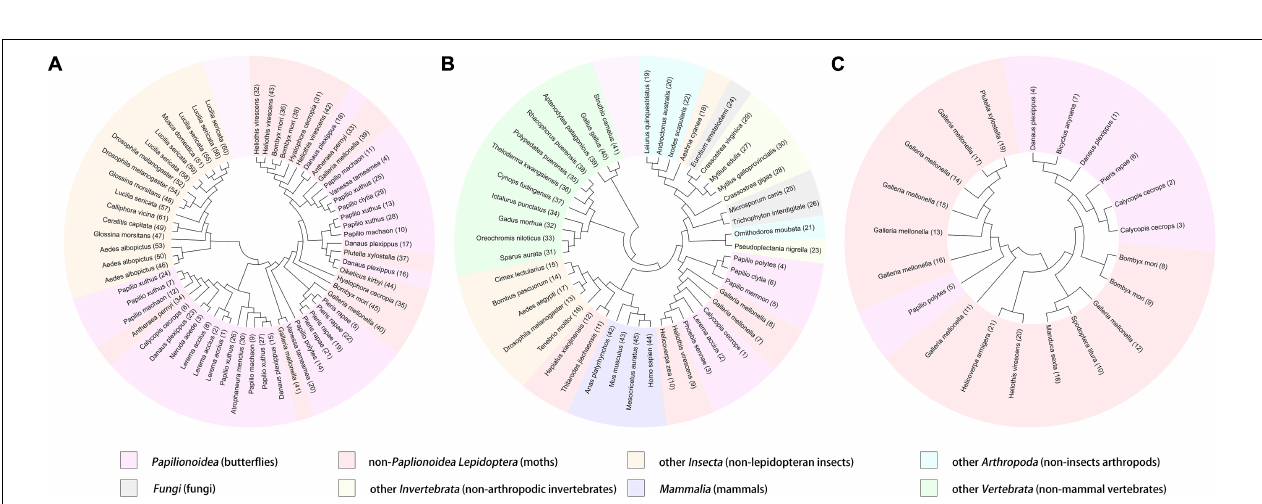
Frontiers in Microbiology |